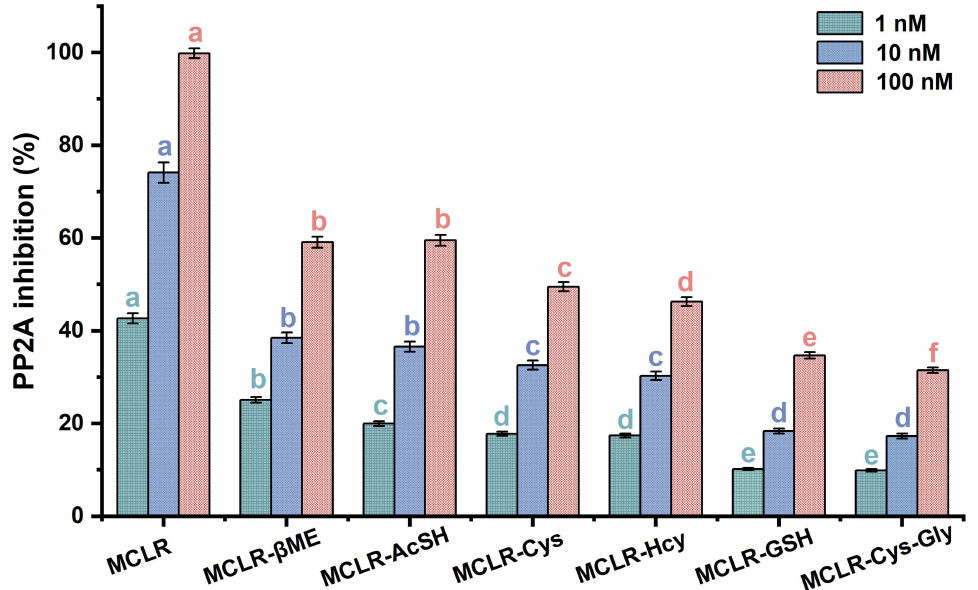
Figure 3. The inhibition effects of MCLR and MCLR-BTPs on PP2A. The error bar is the standard error of three repeated analyses. A one-way analysis of variance (ANOVA) followed by LSD post hoc tests was used to verify significant differences among MCLR and MCLR-BTPs. Different letters indicate significant differences between groups ( p < 0.05), obtained using SPSS